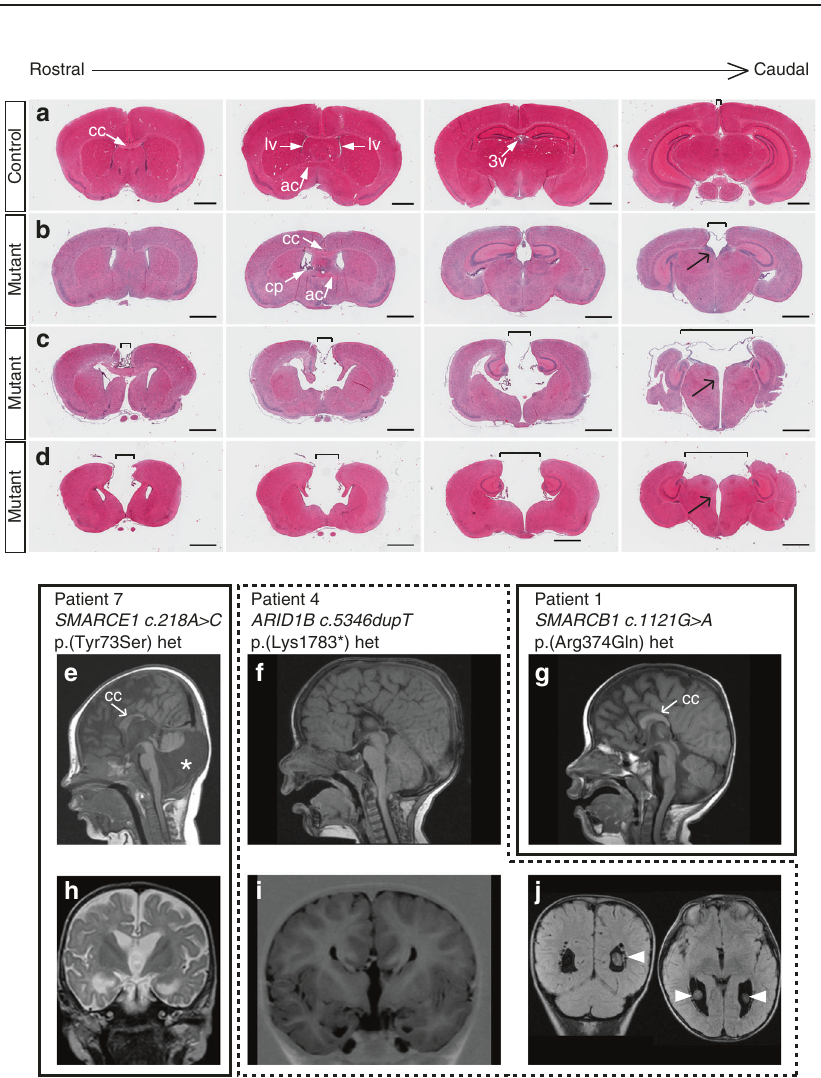
Fig. 1 Phenotypic and genetic analyses of mutant and control mice. a Control and mutant animal (age: 3 weeks). b Brains of 3-week-old mutant mice are smaller and their cerebral hemispheres are separated by a midline gap (arrowheads). c Summary of brain phenotypes in mutant animals. d Cerebelli of 3 – 4-week-old control and mutant animals; right panel: brains were ink-stained for the visualization of fi ssures; h cerebellar hemisphere, v cerebellar vermis. Note the smaller size and reduced foliation of mutant cerebelli. Upper panel: control brain with longitudinal (anterior-posterior) fi ssures (arrowheads) separating the vermis from the two lateral hemispheres. Middle panel: mutant cerebellum with lack of longitudinal fi ssures (arrowheads) and fusion of the two lateral hemispheres (the majority of cases). Lower panel: mutant cerebellum with separated hemispheres that are only rostrally connected (arrows). e Nissl-stained coronal sections of control and mutant cerebelli (3 – 4 weeks of age). Note the midline fusion of lateral hemisphere lobules in the mutants. v cerebellar vermis; asterisk (*) vermis- like midline structure. Scale bars in b , d , e : 1mm. f Inversion of Smarcb1 exon 1 in genomic DNA from E14.5 mutant and control forebrain tissue detected by polymerase chain reaction (PCR). Three primer pairs are used in one reaction, leading to ampli fi cation of a 97-bp product in case of the wild-type allele ( Smarcb1 + ), of a 200-bp product in case of the active, non-inverted, fl oxed allele ( Smarcb1 inv ) due to loxP site and extra DNA sequences, and of a 361-bp product in case of the inactive inverted allele ( Smarcb1 inv Cre + ). Gel electrophoresis of the PCR products shows the presence of inverted and non-inverted alleles in all mutant samples (m1 – m5). g Smarcb1 transcript levels in E14.5 control (c2 – c4) and mutant (m1 – m5) forebrain tissue determined by quantitative reverse transcriptase-PCR. Primers binding to exons 1 and 2 and primers that speci fi cally amplify one of the two Smarcb1 isoforms differing in exon 2 length were applied. Signi fi cantly reduced levels of all three cDNA PCR products were found in mutant ( fi ve animals) compared to control (three animals) samples. All bars display the mean with standard deviations. * p ≤ 0.05, ** p ≤ 0.01 (unpaired two-tailed Student ’ s t test). Source data are provided as a Source Data fi le